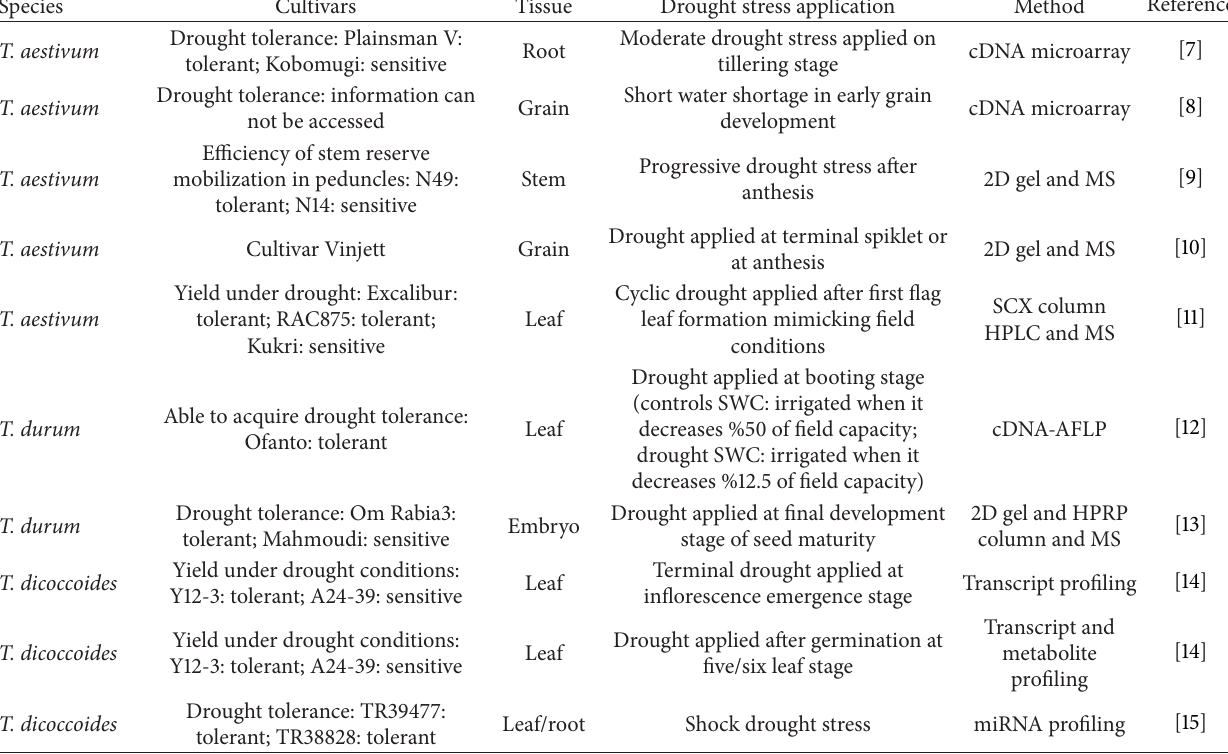
Table 1: Transcript, protein, metabolite profiling studies conducted in the last three years.